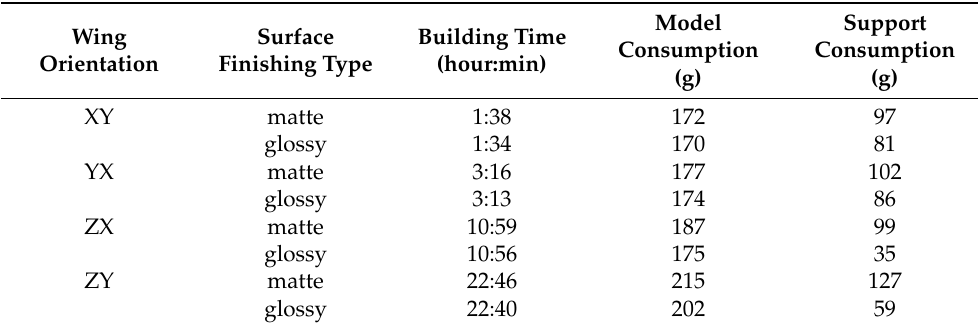
Table 2. Estimated 3D-printing parameters for different orientation on the build platform of the L-SW model.